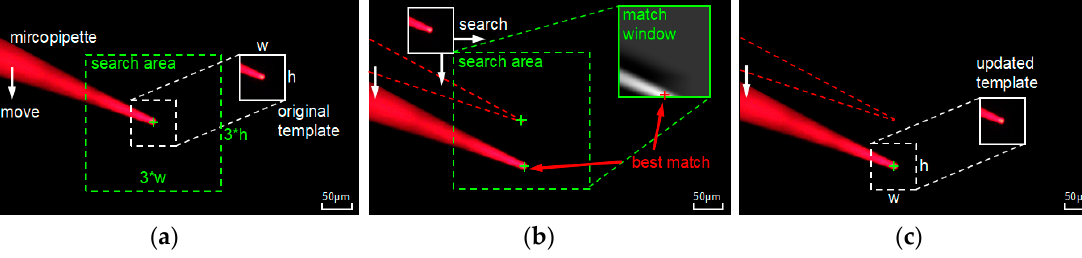
Figure 4. Process of neighborhood search based micropipette tracking: ( a ) Locating of micropipette tip and generating template; ( b ) Searching in the neighborhood and locating the new position of micropipette tip; ( c ) Updating match template for subsequent tracking.